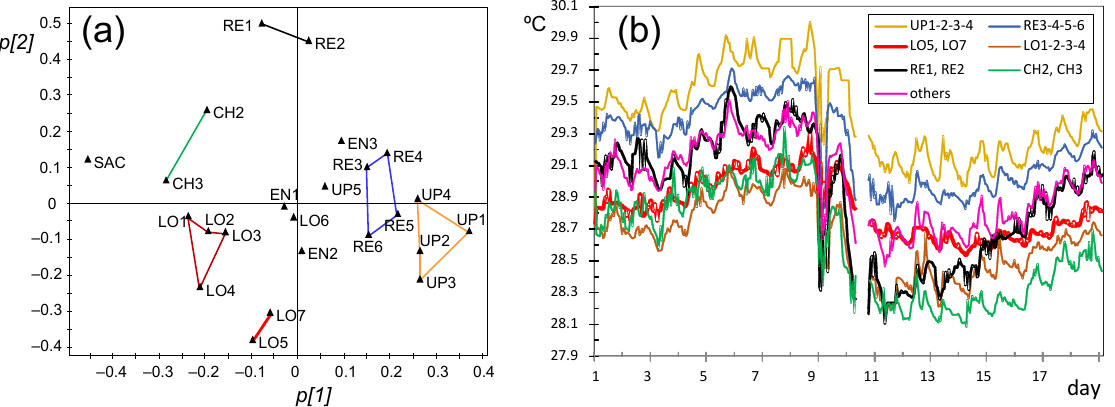
Figure 18. PCA of daily medians for the period of days 1–30 after discarding nodes CH1 and OUT: ( a ) loading plot for PC1 and PC2 ( p[2] vs. p[1] loadings), ( b ) time series of hourly values from day 1 to 18 (1–18 of August 2017). Nodes appearing close to each other in ( a ) were joined together and their trajectories were averaged in ( b ). “Others” accounts for EN1, EN2, EN3, UP5, and LO6.